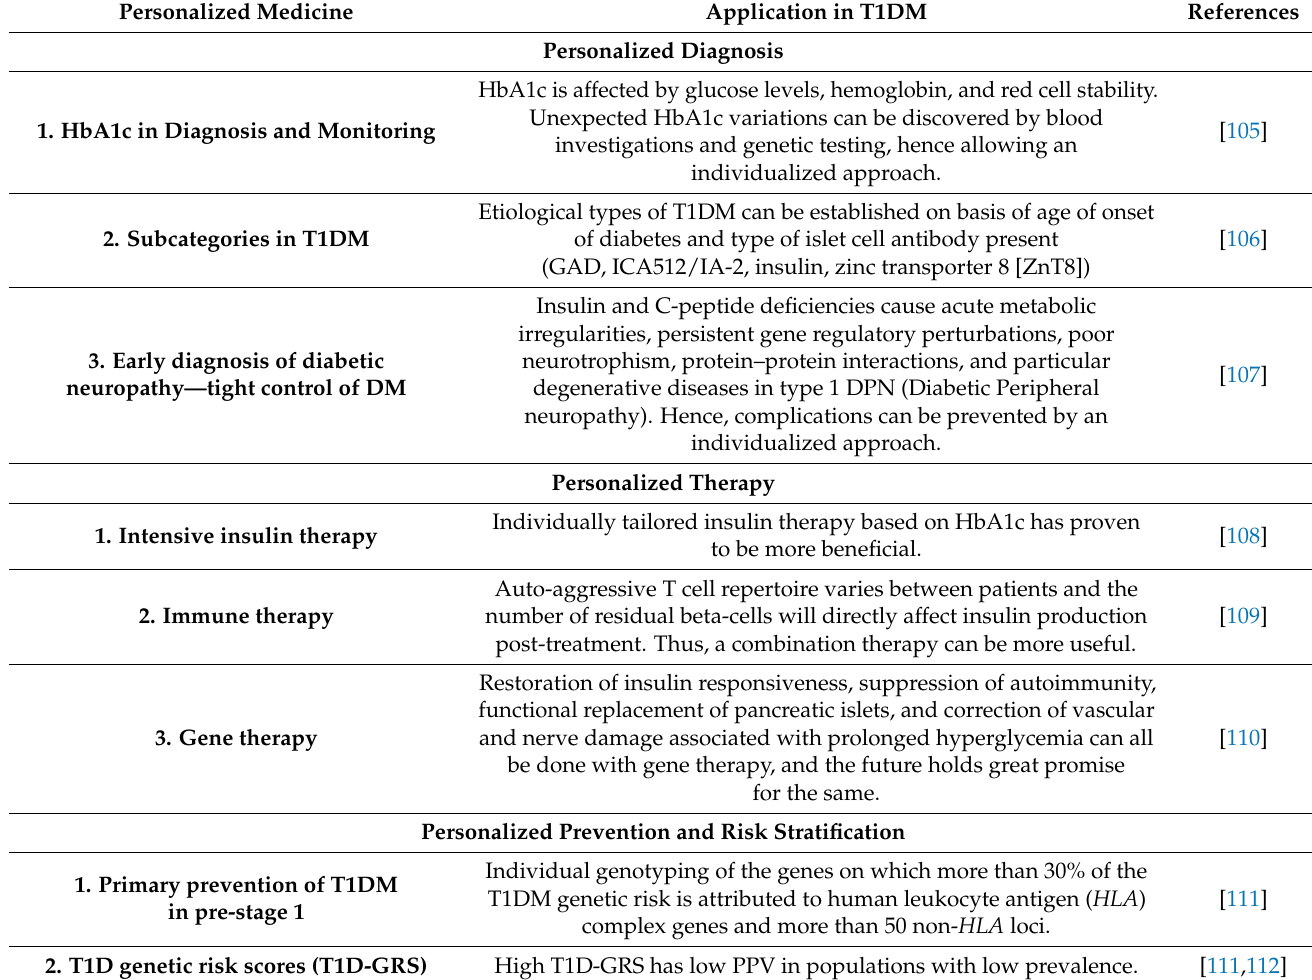
Table 2. Personalized medicine and T1DM